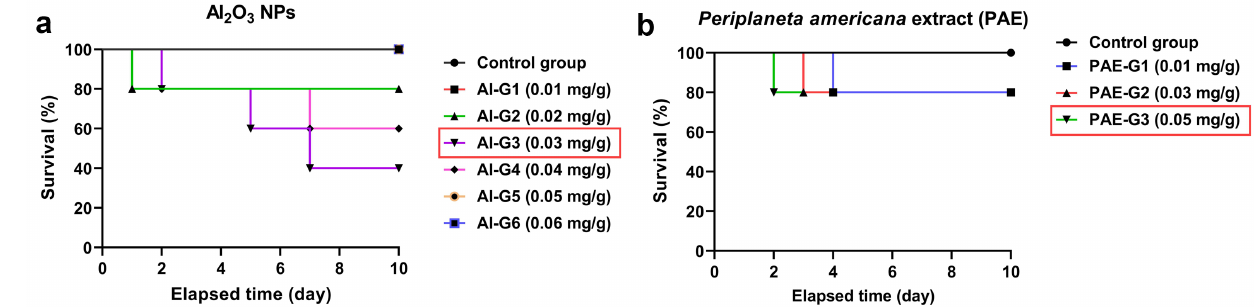
Figure 2. Mortality analyses for different groups of male locusts after injection with a single dose of either ( a ) Al 2 O 3 NPs or ( b ) PAE in a dose-dependent manner after monitoring for 10 days. For the Al 2 O 3 NPs treatment, six groups of male locusts along with the control group (10 insects/group) were established and injected with the nanoparticles at different doses of 0.01, 0.02, 0.03, 0.04, 0.05, and 0.06 mg/g body weight, respectively, and the Chi square was 12.43 with a p < 0.05. For PAE,